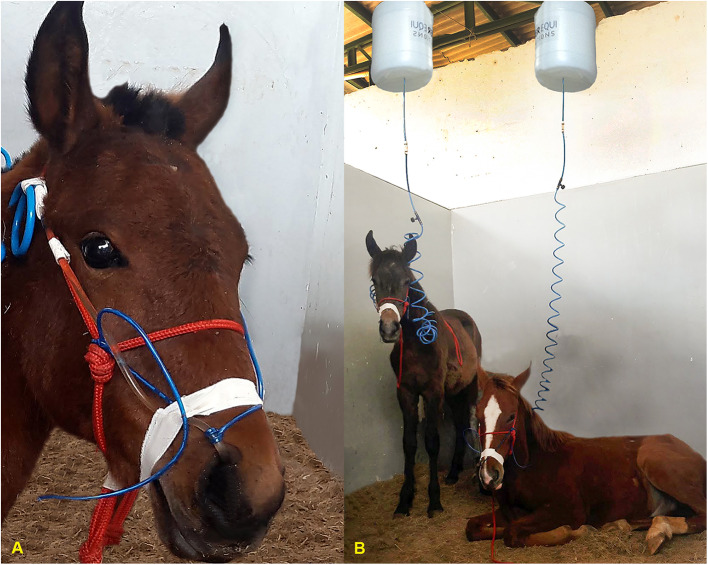
(A) Highlight for the fixation technique of the nasogastric probe to the halter and face of the animals. (B) Animals during enteral fluid therapy phase.